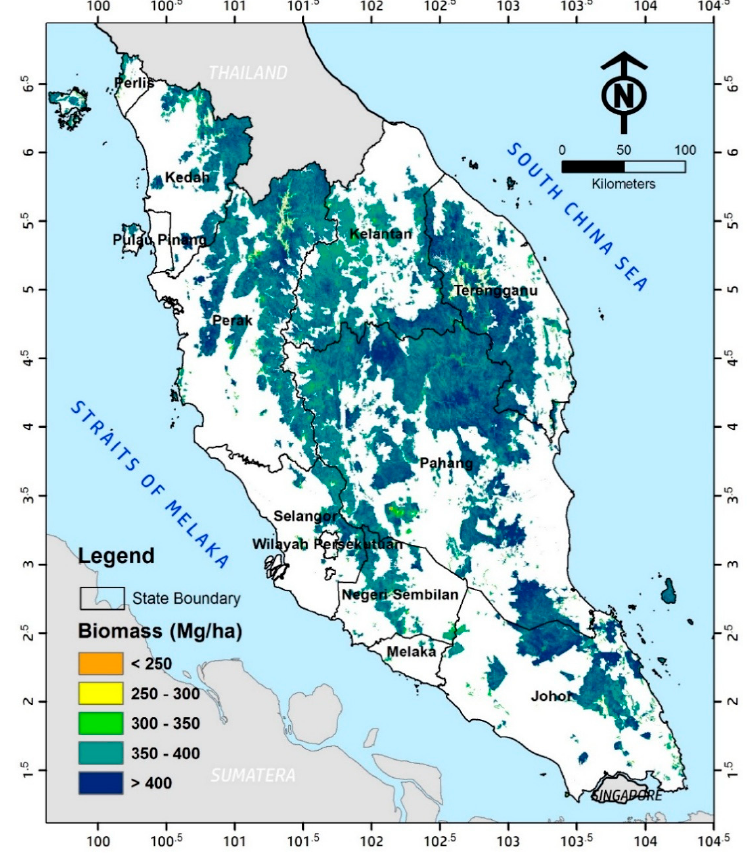
Figure 12. Spatially distributed map of AGB within the study area.